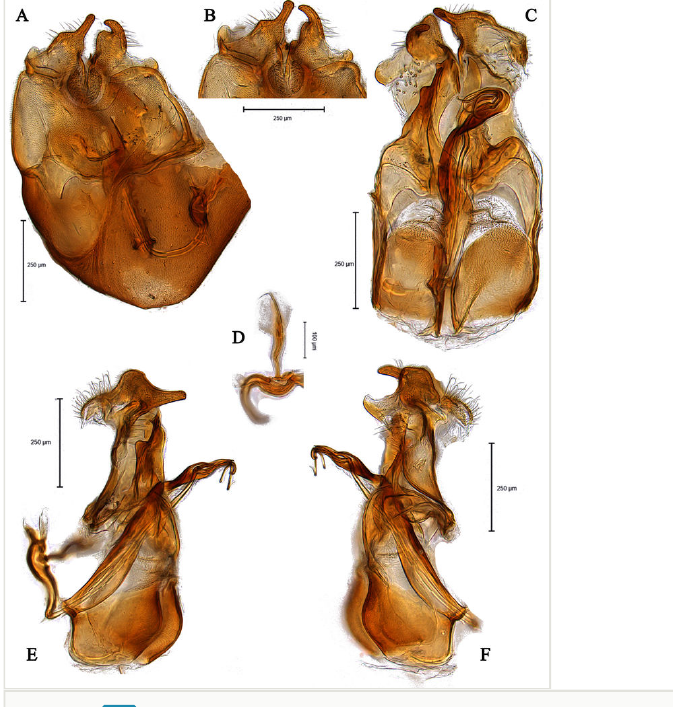
Figure 7. Male genitalia of Eudorylas bipertitus (JSS50815) (A) in dorsal view; (B) surstyli in dorsal view; (C) in ventral view; (D) ejaculatory apodeme; (E, F) in lateral